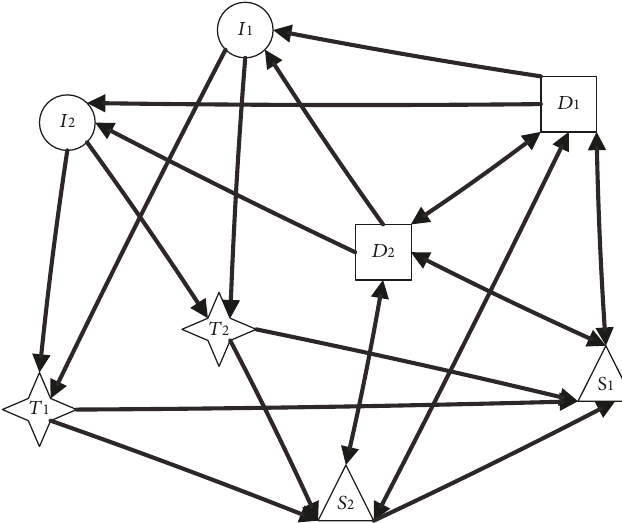
Figure 3: An MAV/UAV collaborative combat network.